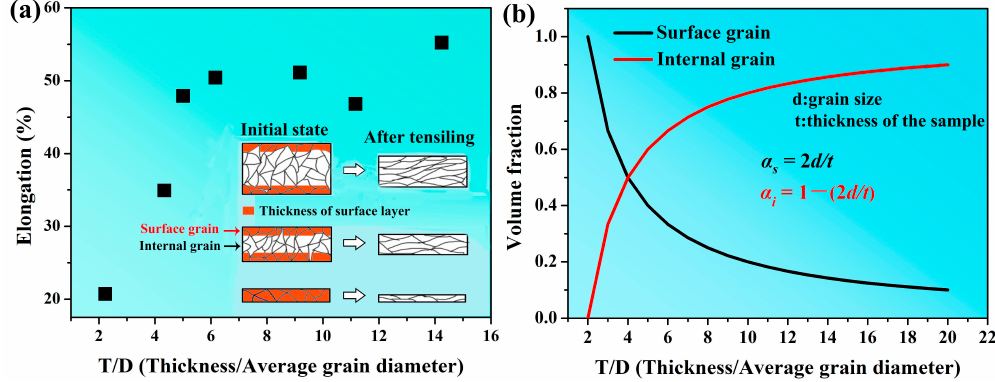
Figure 6. Elongation curves ( a ) and volume fraction ( b ) with T / D (the insert showing the model of sample through tensile test).